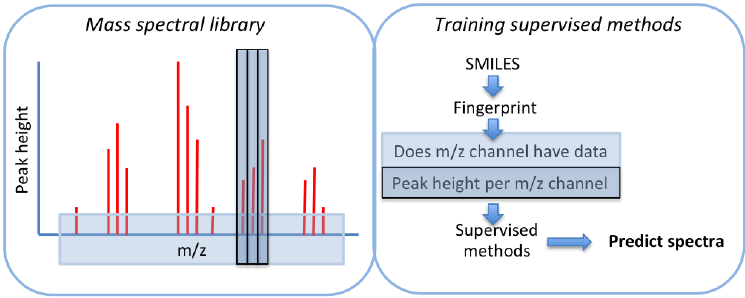
Figure 1. Schematic of the workflow used in the training process. For a normalised mass spectrum, the SMILEs string associated with each compound is combined with a given molecular fingerprint to train methods to predict the occurrence of a given m/z channel and then a peak